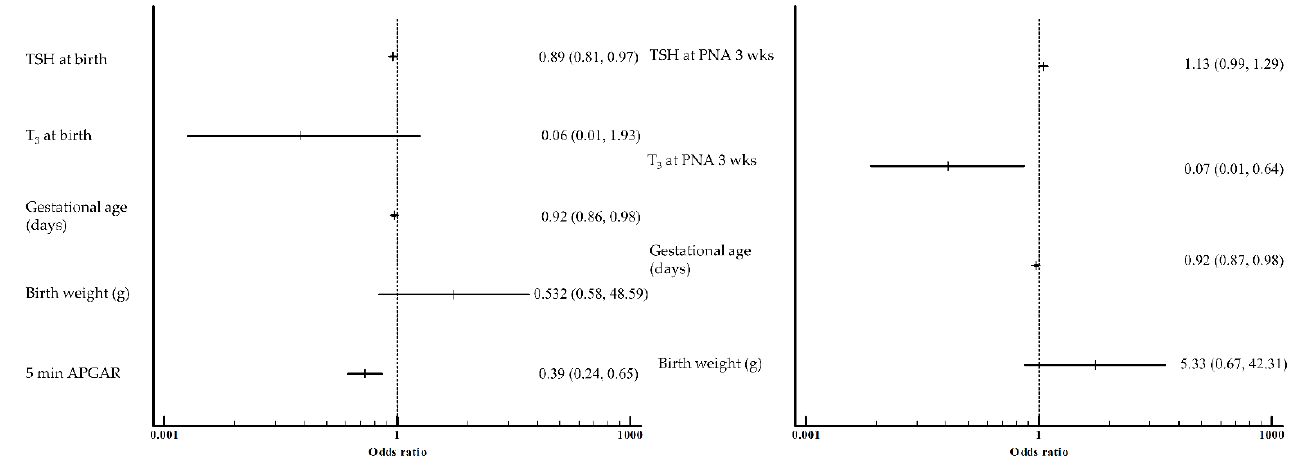
Figure 3. Adjusted odds ratio and their 95% confidence intervals for RDS after multivariate logistic regression analysis adjusted with confounders. Effect of TSH and T 3 at birth (A) and TSH and T 3 at PNA 3 weeks. CI, confidence interval; OR, odds ratio; T 3 , triiodothyronine; TSH, thyroid-stimulating hormone; PNA, postnatal age